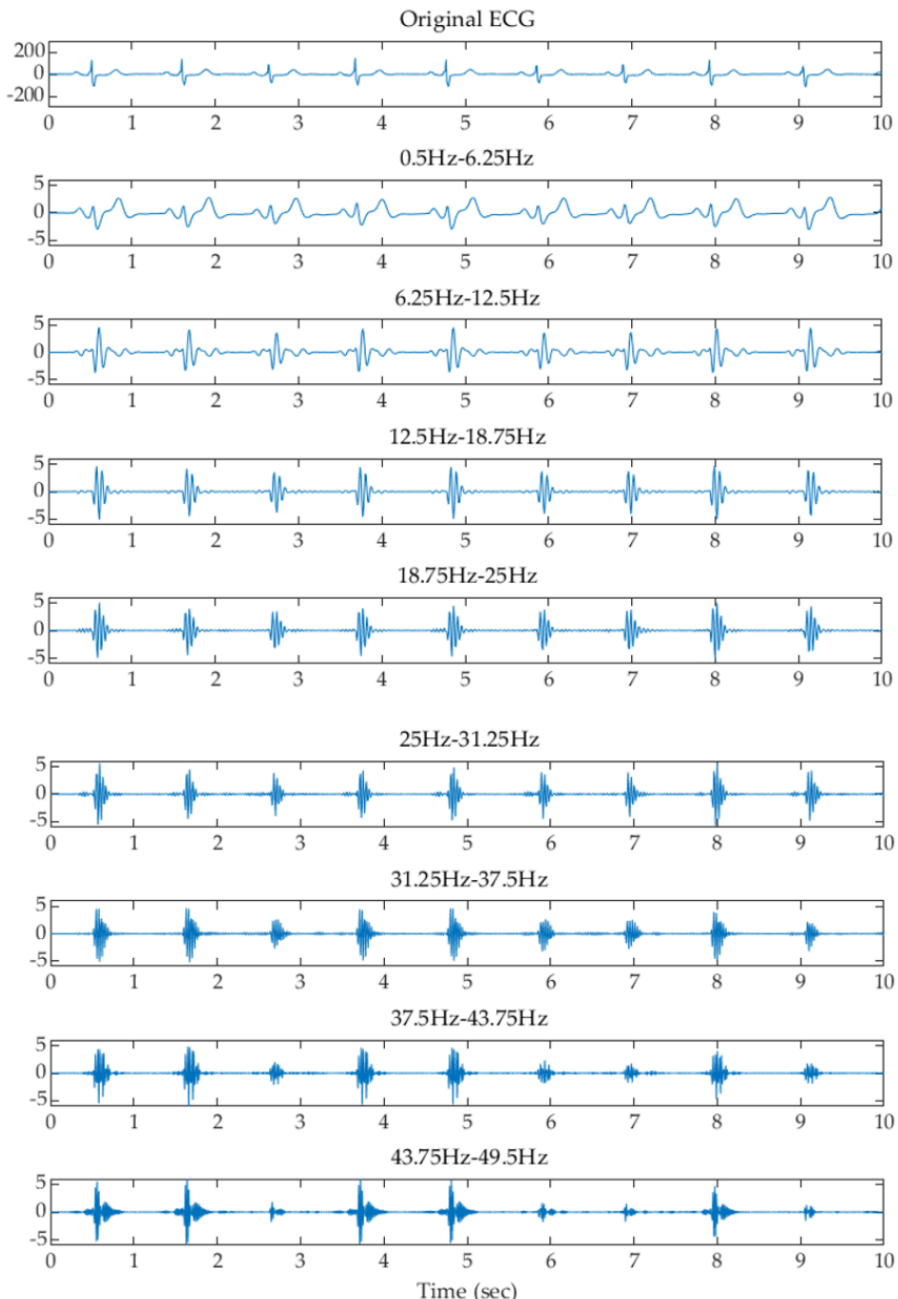
Figure 5. Examples of the original ECG and the signals after filtering using the filter bank with 8 Butterworth filters and z-score